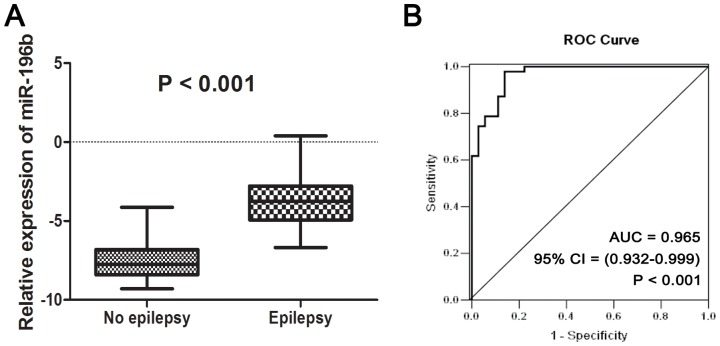
Association of miR-196b expression by qPCR with the occurrence of pre-operative seizures in LGGs.(A) Patients with pre-operative seizures exhibited higher expression levels of miR-196b when compared with those without pre-operative seizures. (B) The diagnostic role of miR-196b for determining the occurrence of pre-operative seizures using receiver operating characteristic curve analysis.